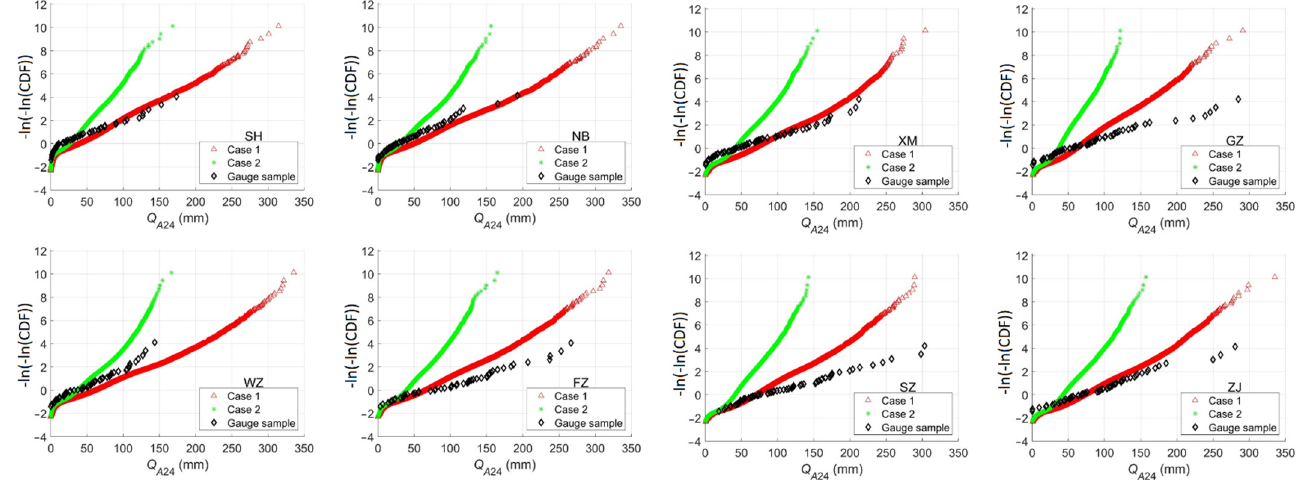
Figure 12. Comparison of Q A 24 due to TC rainfall for selected sites on the Gumbel probability paper, where the vertical axis represents the value of − ln ( − ln(CDF)) in which CDF denotes the value of the (empirical) cumulative probability distribution function (CDF).